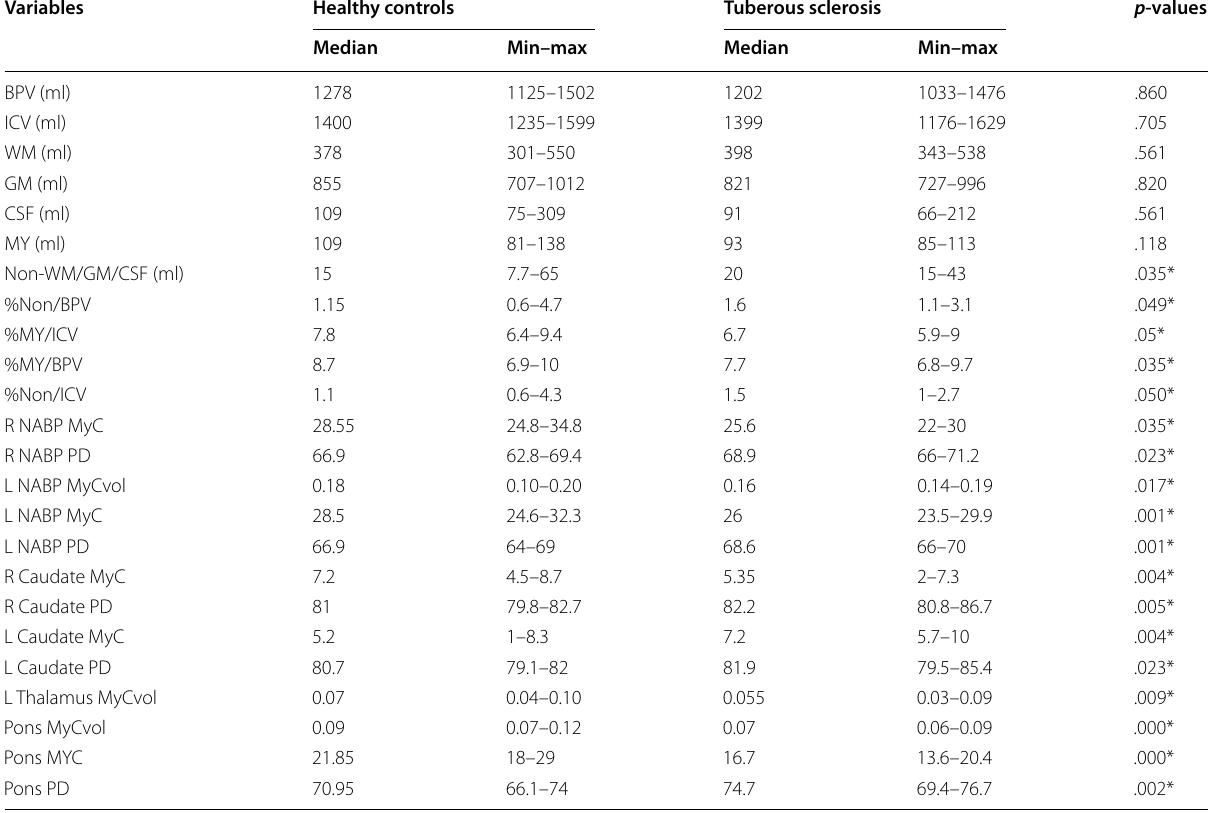
Table 2 Comparison of SyMRI parameters of TSC patients and healthy controls